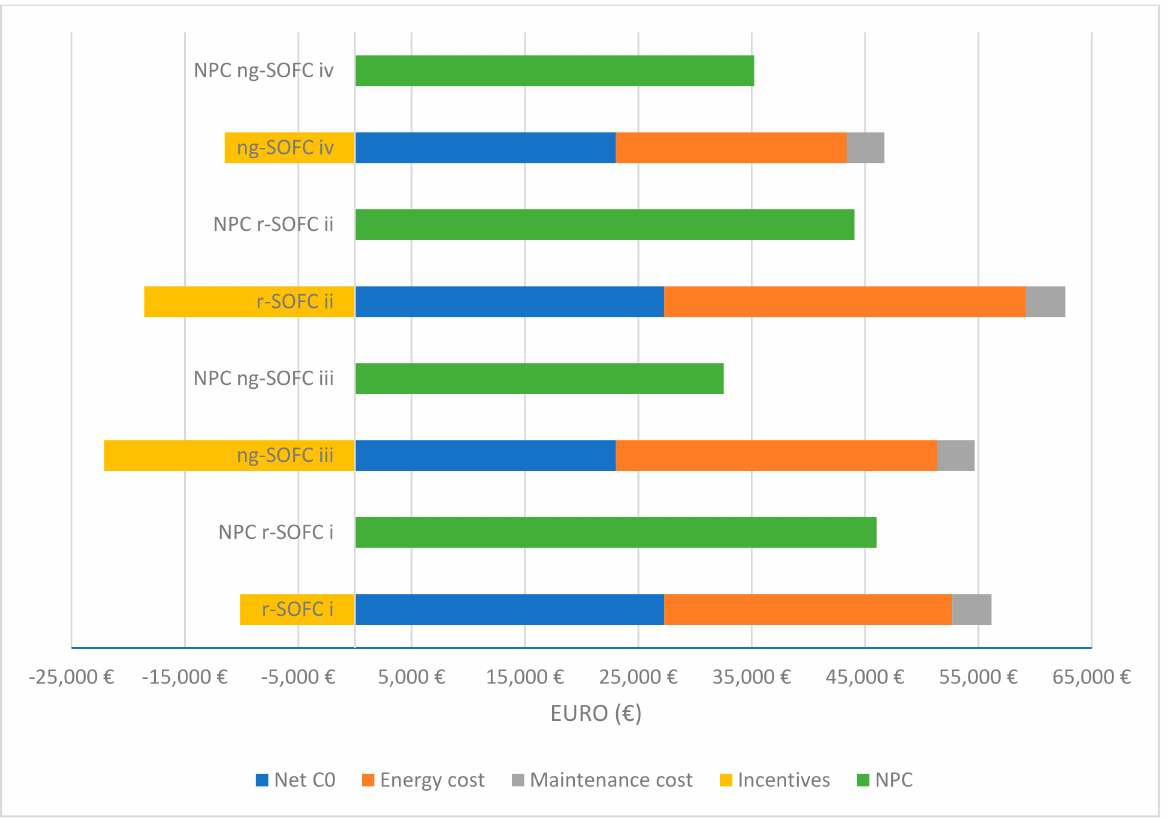
Figure 3. Costs and incentives of the systems in the self-consumers group